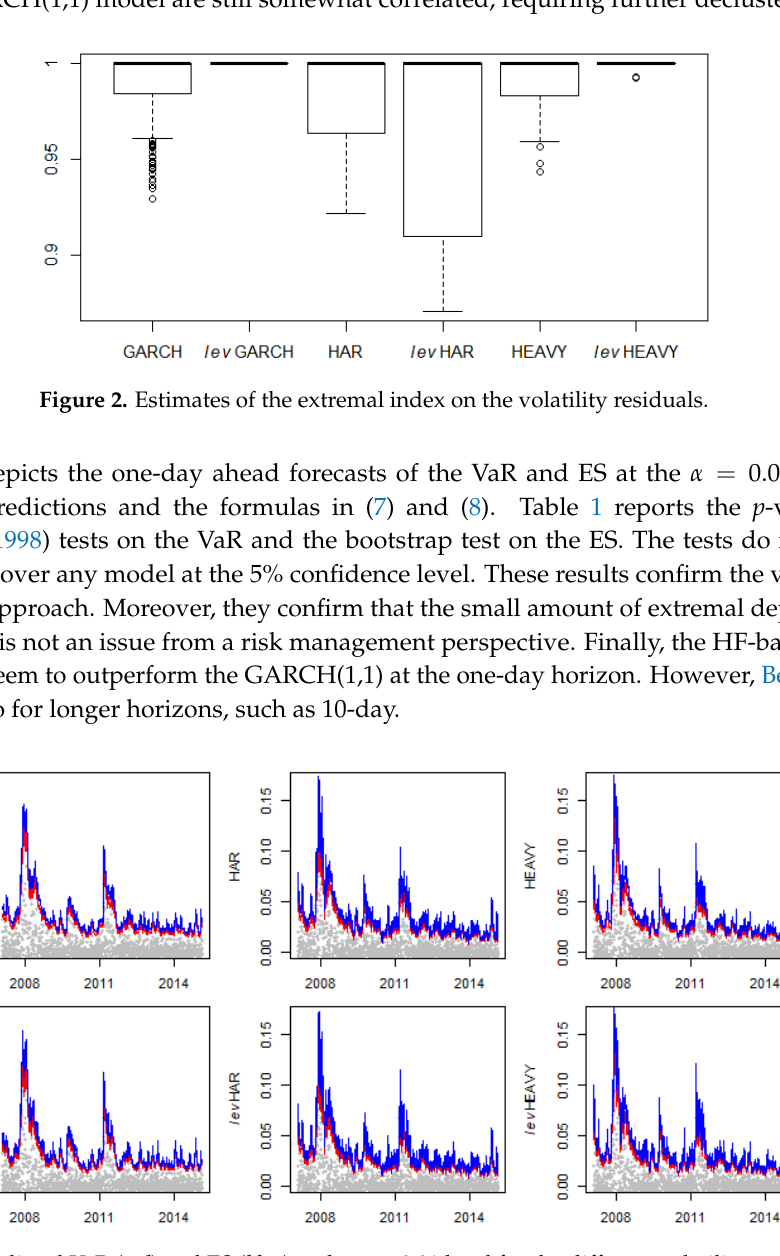
Figure 3. Predicted VaR ( red ) and ES ( blue ) at the α = 0.01 level for the different volatility models, and losses of the validation sample ( grey